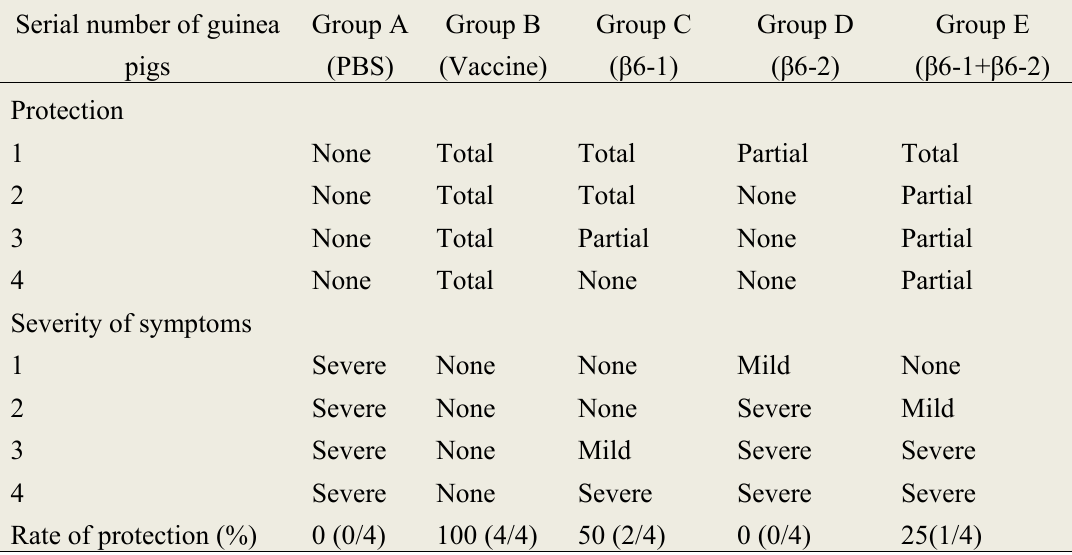
Table 1. Protection and symptom severity in guinea pigs given the viral challenge. Serial number of